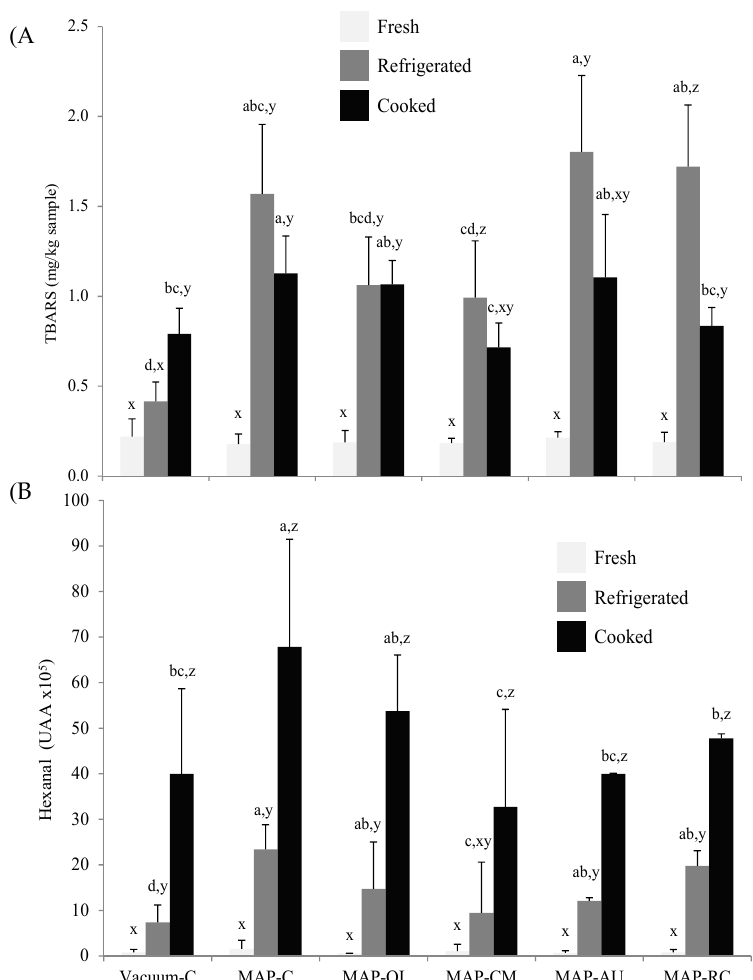
Figure 1. Lipid oxidation markers, thiobarbituric acid reactive substances (TBARS) ( A ) and hexanal counts ( B ) in fresh, refrigerated and cooked lamb cutlets. Sample description: Vacuum-C (cutlets packed in a vacuum package and no added extract), MAP-C (cutlets packed in a high-oxygen packaging atmosphere (High-ox-MAP) and no added extract), MAP-QI (cutlets packed in High-Ox-MAP and treated with QI extract), MAP-CM (cutlets packed in a High-Ox-MAP and treated with CM extract), MAP-AU (cutlets packed in a High-Ox-MAP and treated with AU extract) and MAP-RC (cutlets packed in a High-Ox-MAP and treated with RC extract). a–d Different letters on top of bars denote significant differences between treatments within a processing stage (Fresh, refrigerated or cooked). x–z Different letters on top of bars denote significant differences between processing stages within a particular treatment.